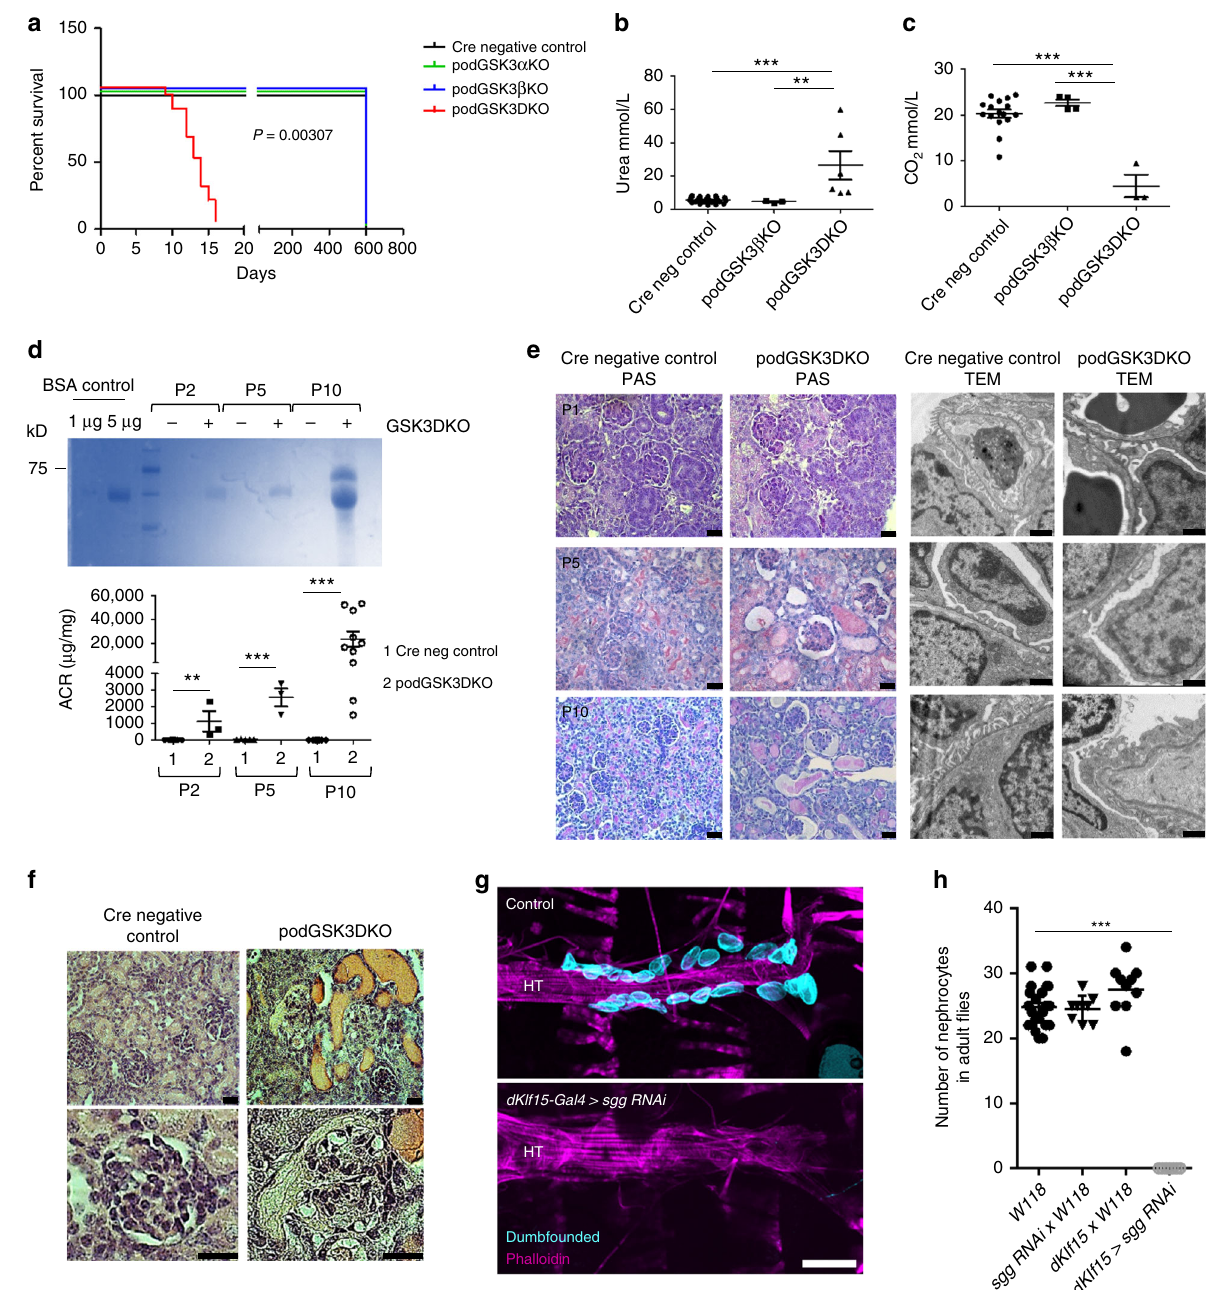
Fig. 1 Developmental loss of podocyte/nephrocyte GSK3 is catastrophic. a Kaplan – Meier survival plot. Log-rank (Mantel-Cox test) p = 0.00307 (Cre negative controls n = 3; podGSK3 α KO n = 3; podGSK3 β KO n = 3; podGSK3DKO n = 19 mice). b podGSK3DKO mice are in renal failure with elevated urea levels at day 11 (one-way ANOVA, Tukey ’ s post hoc test ** p < 0.01; *** p < 0.001 Cre negative controls n = 25; podGSK3 β KO n = 3; podGSK3DKO n = 6 mice). c podGSK3DKO mice are acidotic at day 11 with signi fi cantly lower bicarbonate levels (one-way ANOVA, Tukey ’ s post hoc test *** p < 0.001 Cre negative controls n = 16; podGSK3 β KO n = 4; podGSK3 DKO n = 3 mice). d Rapid progression of kidney disease in the fi rst 11 days of life in podGSK3DKO mice. Top: a Coomassie gel showing progression of albuminuria in an illustrative knockout and control mouse (2 μ l of urine loaded in each lane). See also Supplementary Fig. 1 g. Bottom: graph showing the albumin:creatinine ratio (ACR) in a population of podGSK3DKO and control mice ( t test ** p < 0.01; *** p < 0.001 Cre negative controls P2 n = 8; podGSK3DKO P2 n = 3; Cre negative controls P5 n = 5; podGSK3DKO P5 n = 3; Cre negative control P10 n = 10; podGSK3DKO P10 n = 10 mice). e PAS (scale bar 25 μ m) and transmission electron microscopy (scale bar = 1 μ m) of podGSK3DKO and control mice at P1, P5 and P10. f H & E at P10 of podGSK3DKO and control mouse shows tubular protein casts and vacuolated glomeruli Scale bar = 25 μ m. g Speci fi